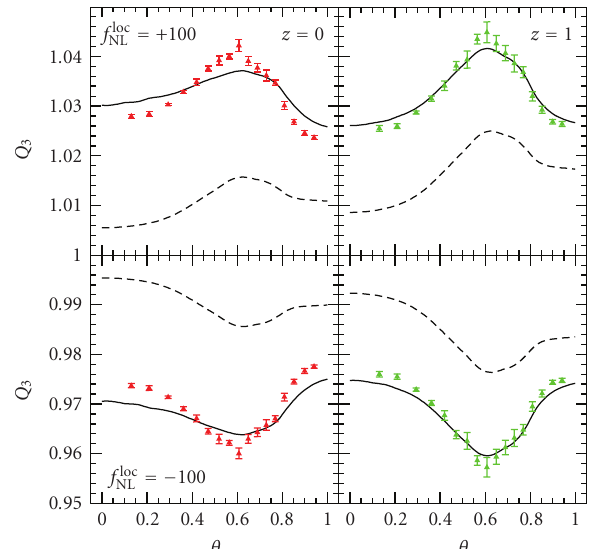
Figure 3: Reduced matter bispectrum Q 3 as a function of the angle θ between k 1 and k 2 for a fixed k 1 = 0 . 094 hMpc − 1 and k 2 = 1 . 5 k 1 . The panels show ratios between the non-Gaussian and = +100 (top) and − 100 (bottom). Dashed Gaussian Q 3 for f loc NL lines correspond to tree-level PT while continuous line indicates the 1-loop PT